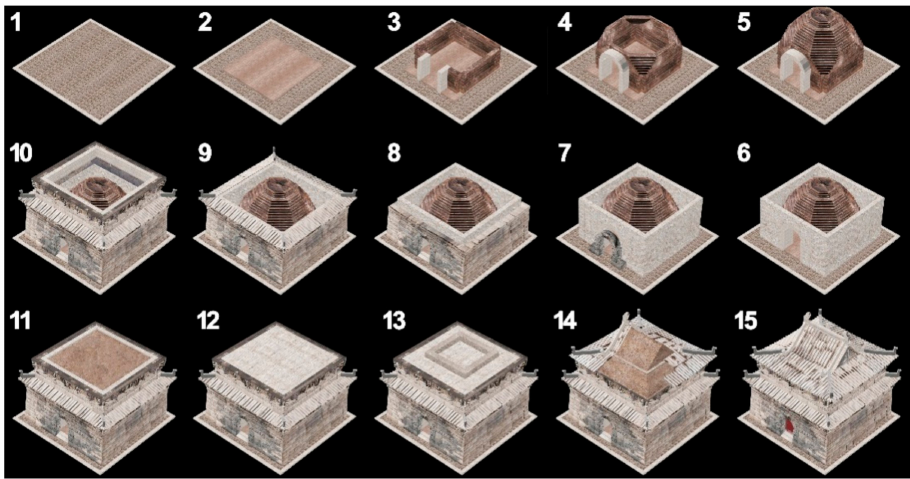
Figure 11. Construction process diagram of the Limestone Hall.